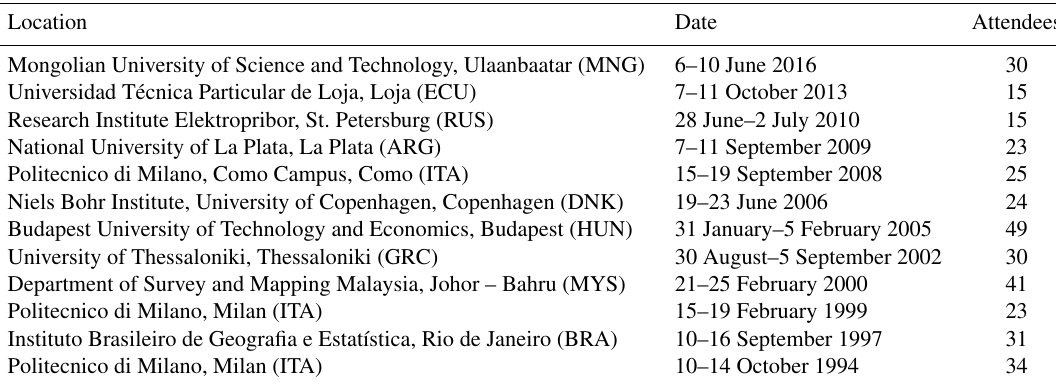
Table 1. List of the geoid schools organized by the ISG since its foundation.